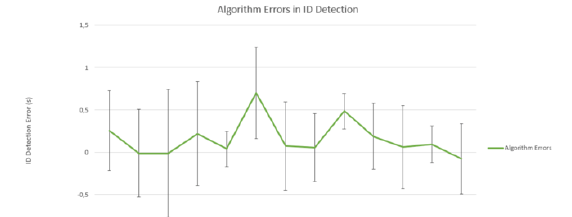
Figure 4: Inversion duration detection algorithm mean